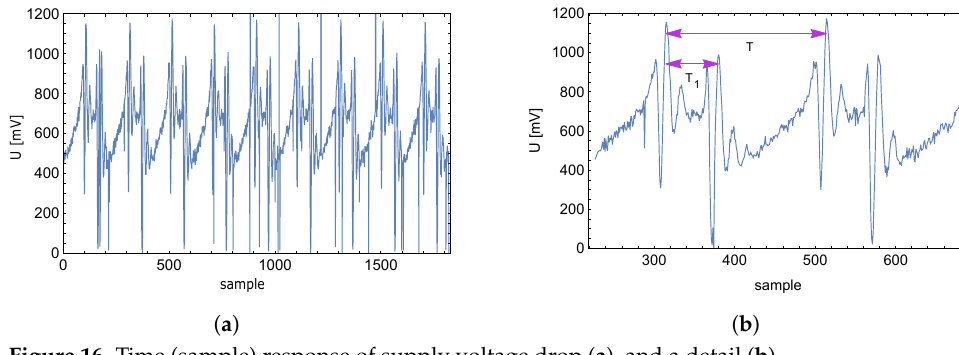
Figure 16. Time (sample) response of supply voltage drop ( a ), and a detail ( b ).